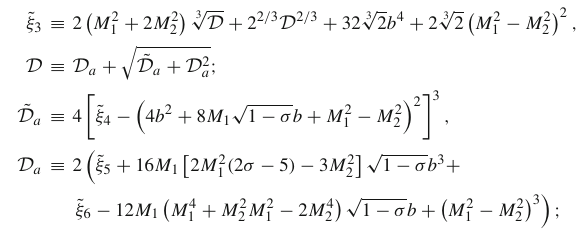
the intensity of the perfect-fluid dark matter, are considered. k is in the ranges k / M ∈] − 7 . 18 , 2 [ . For k = 0 the line element describes the Kerr